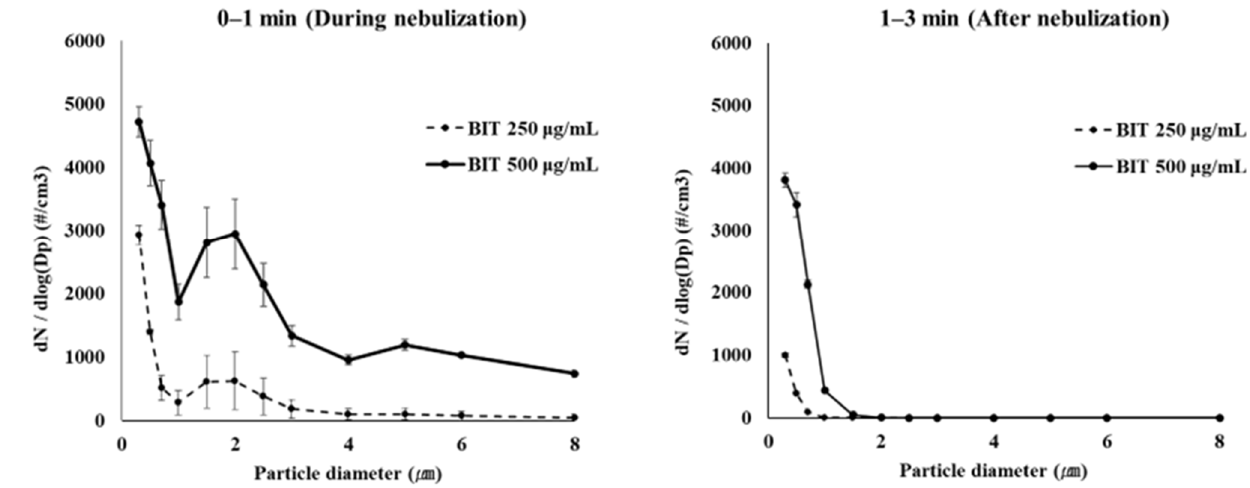
Figure 4. Particle size distribution of BIT aerosols (250 and 500 μ g/mL) in number measured in an in-house-built exposure chamber.